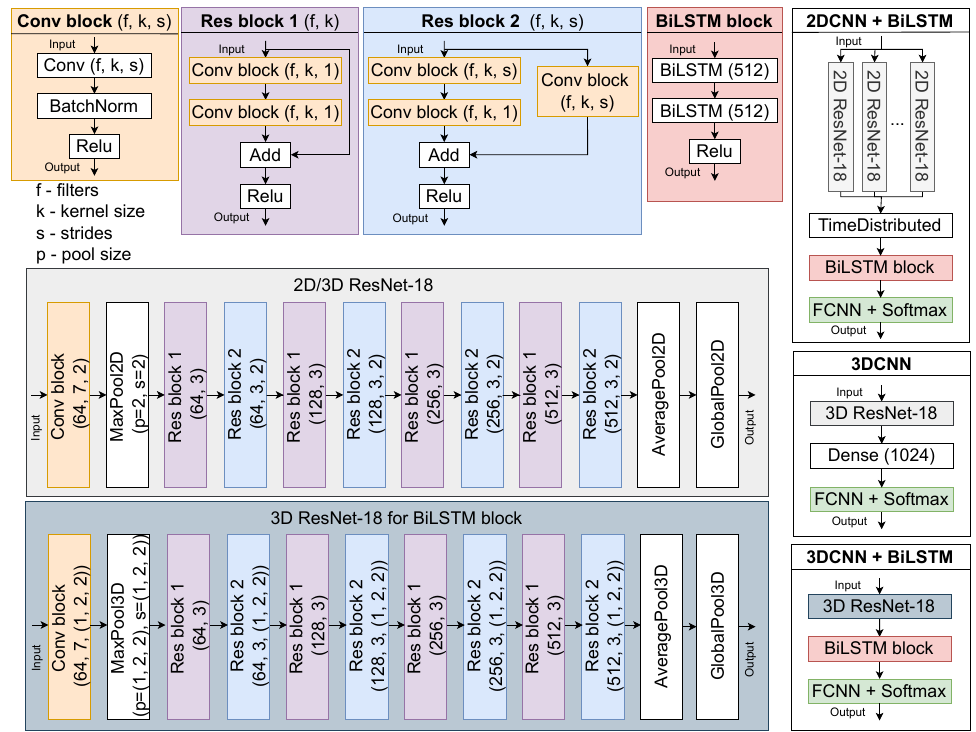
Figure 3. Model architectures for visual speech